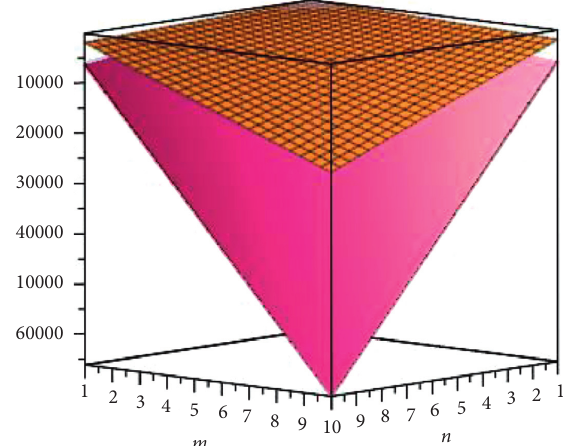
Figure 4: Graphfor ( α � 2 ) mn ( 6 × 4 2 ) + 4 2 m − 4 2 n ≤ χ